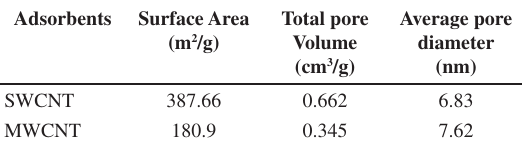
Table 2. Textural properties of SWCNT and MWCNT adsorbents. Adsorbents Surface Area (m 2